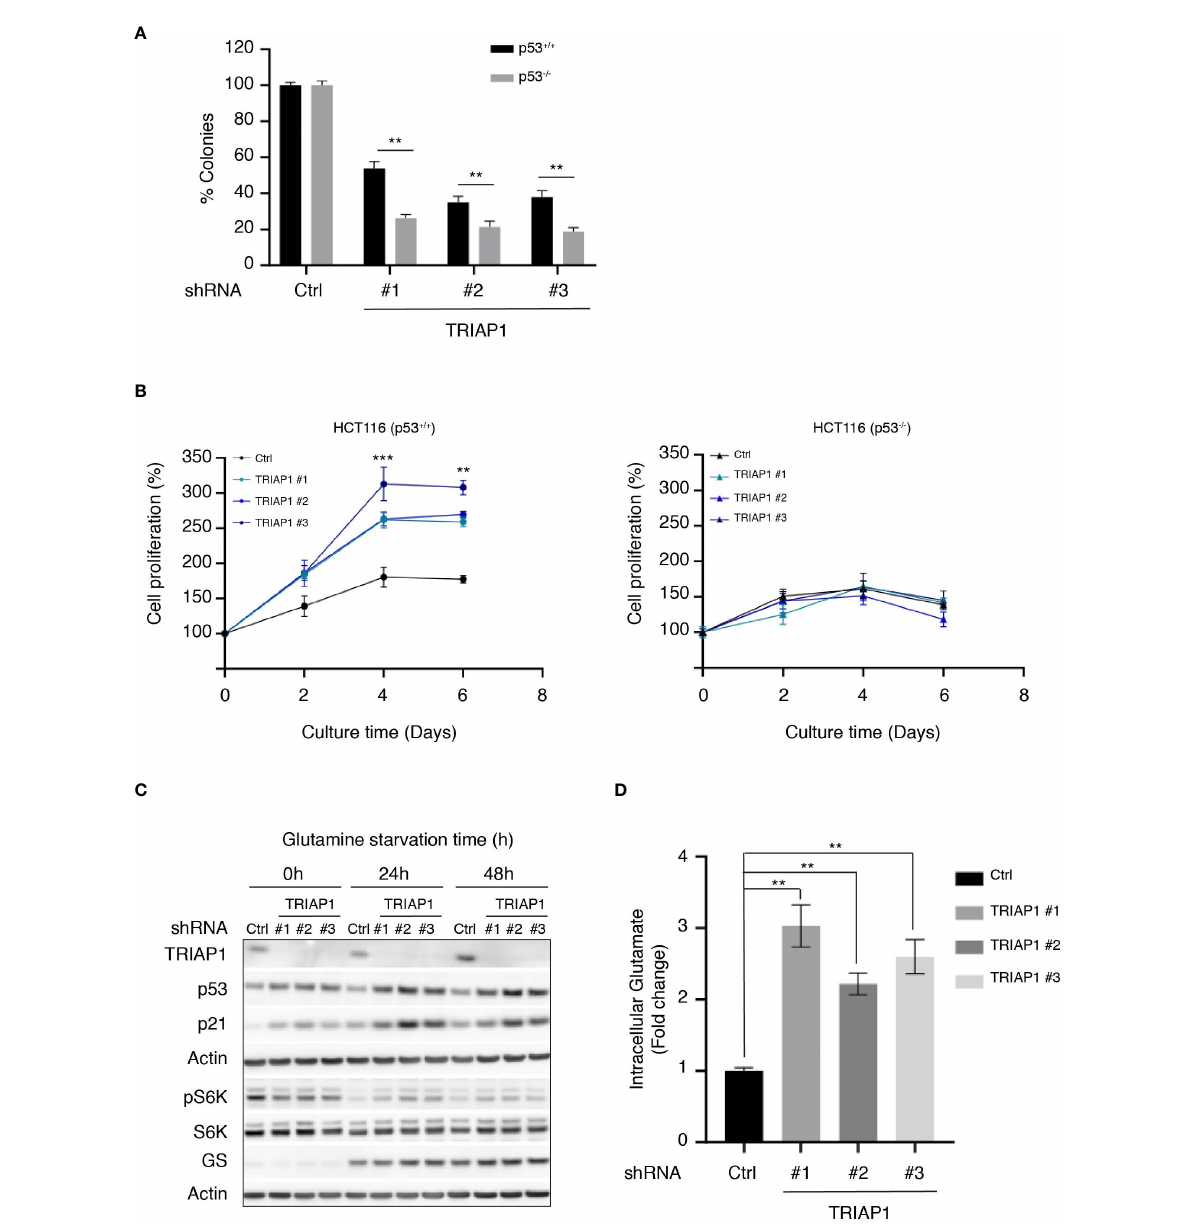
FIGURE 6 TRIAP1 depletion exacerbates a p53-dependent adaptation to glutamine deprivation. (A) Clonogenic assay of HCT116 p53 +/+ or p53 -/- transduced with lentiviral control (shRNA Ctrl) or TRIAP1 (shRNA TRIAP1#1, #2, #3) shRNAs. Cells were seeded at a density of 500 cells/well in six-well plates. Seven days after, cells were stained with crystal violet and the number of clones was counted. Bar charts show the percentage of counted colonies relative to control cells. Data are represented as mean ± SEM (n = 3). Wilcoxon tests were used for statistical comparisons. *p < 0.05, **p < 0.01, ***p < 0.001. (B) HCT116 cells p53 +/+ (left panel) or p53 -/- (right panel) were transduced with lentiviral control (Ctrl) and TRIAP1 (TRIAP1 #1, #2, and #3) shRNAs. Five days after transduction, cells were seeded in complete medium. After 24 h (day 0), the medium was replaced by the starvation one (10 mM glucose, 1 mM pyruvate, no glutamine). The cell proliferation rate was determined every 2 days by manual counting and represented as percentage of day 0. Data are shown as mean ± SEM (n = 6). Kruskal – Wallis tests were used for statistical comparisons. *p < 0.05, **p < 0.01, ***p < 0.001. (C) Immunoblot analysis of extracts of HCT116 P53 +/+ cells transduced with lentiviral control (Ctrl) and TRIAP1 (TRIAP1 #1, #2, #3) shRNAs and grown in glutamine starvation conditions for the indicated times. (D) Intracellular glutamate levels were quanti fi ed in HCT116 P53 +/+ cells transduced with lentiviral control (Ctrl) or TRIAP1 (TRIAP1 #1, #2, #3) shRNAs and cultured in glutamine starvation medium for 72 h. Data are represented as mean ± SEM (n = 3) of the fold change related to control cells. Kruskal – Wallis tests were used for statistical comparisons. **p < 0.01, ***p <